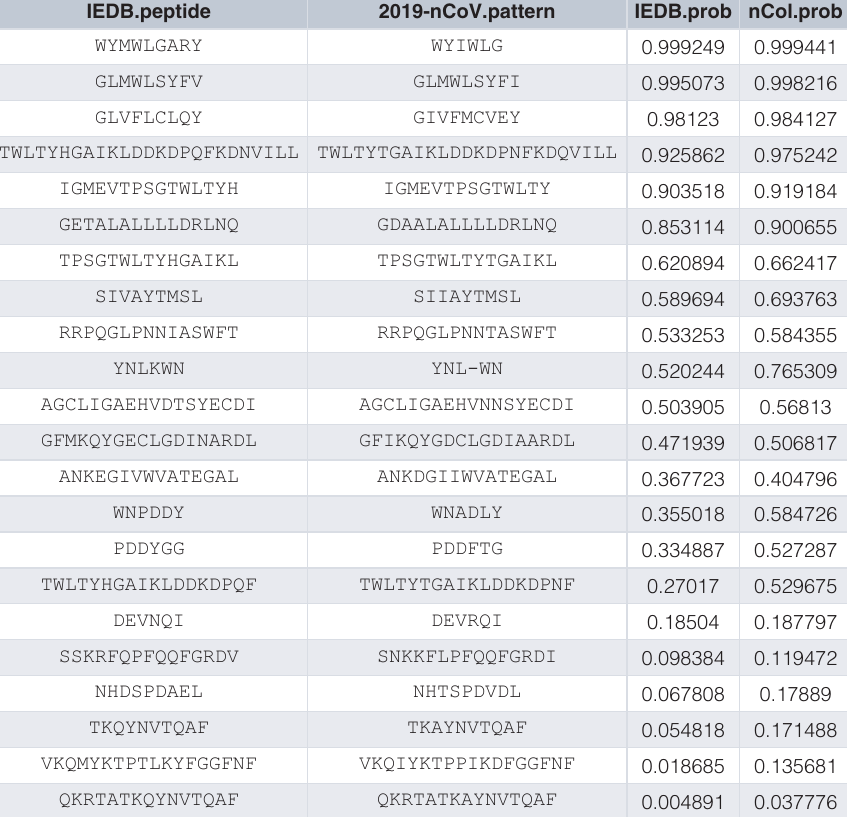
Table 2. List of 22 2019-nCoV peptides having a higher predicted immunogenicity score than their target peptides. IEDB.peptide